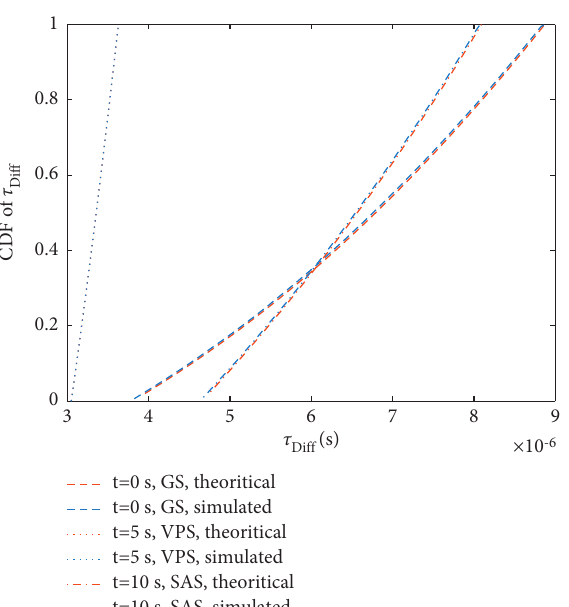
Figure 8: The CDFs of τ